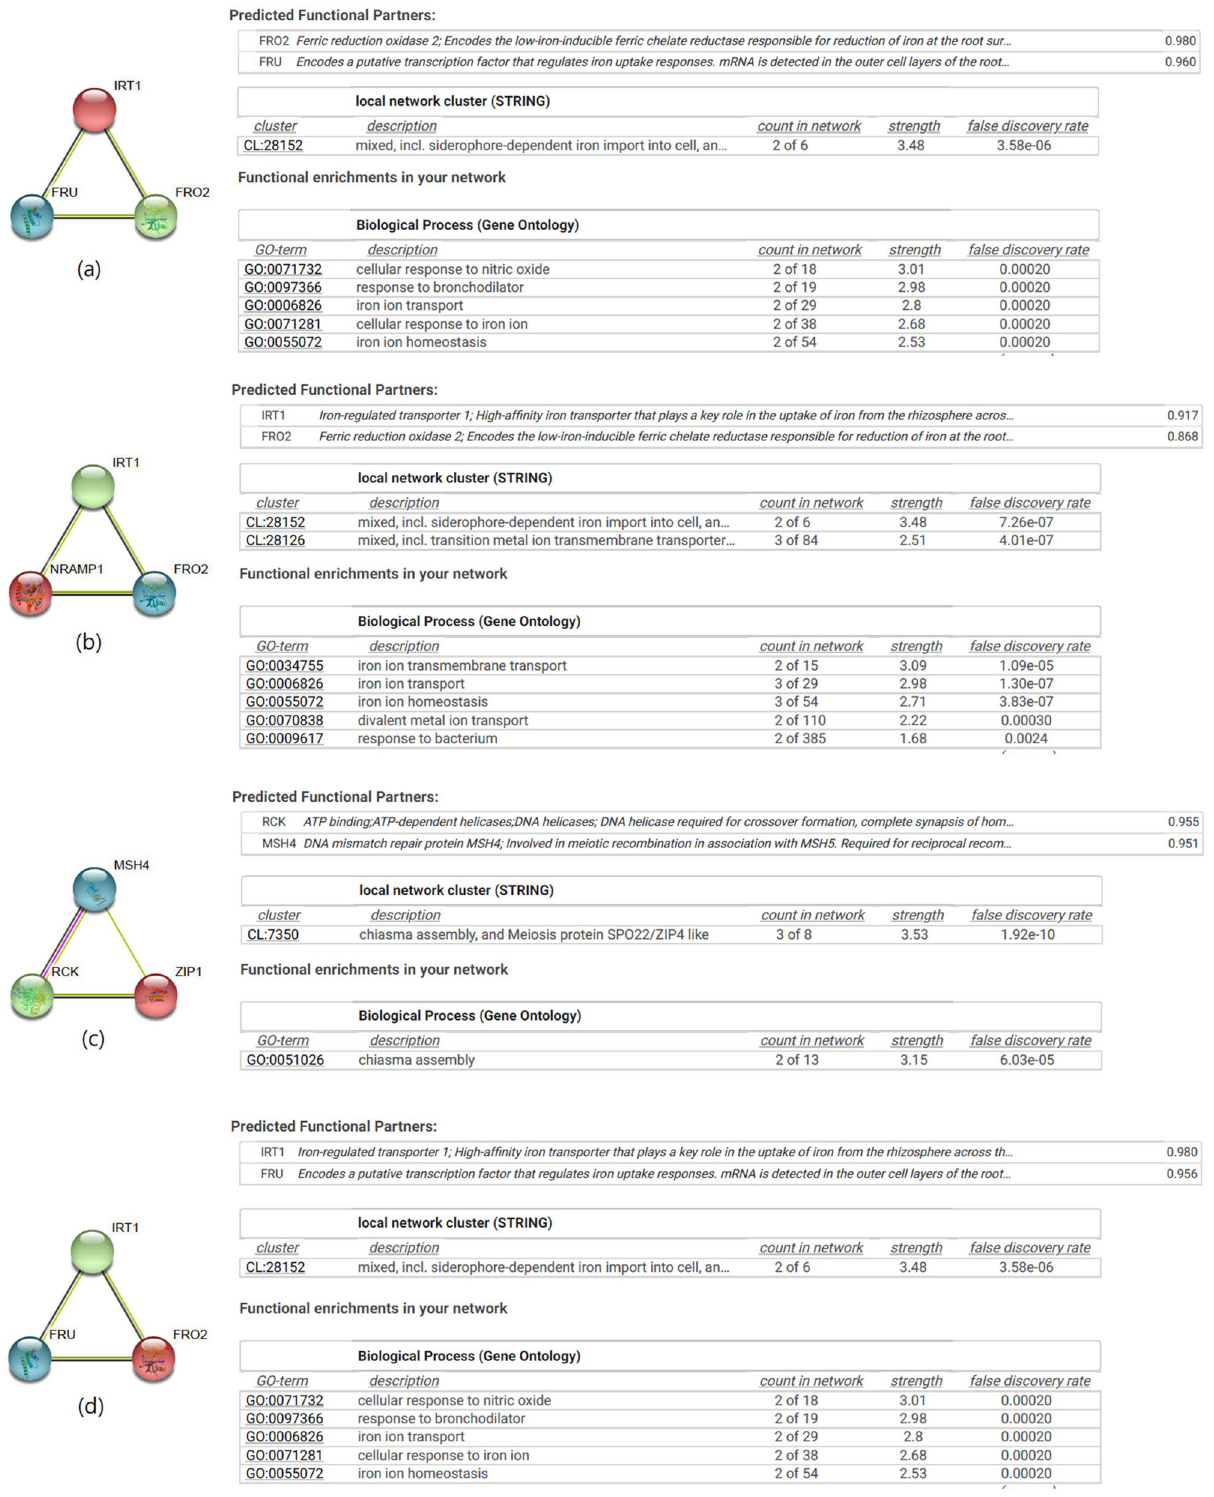
Figure 5. Gene interaction partners and gene network analysis of HaIRT1 ( a ), HaNramp1 ( b ), HaZIP1 ( c ) and HaFRO2 ( d ). Interactome was generated using Cytoscape for STRING